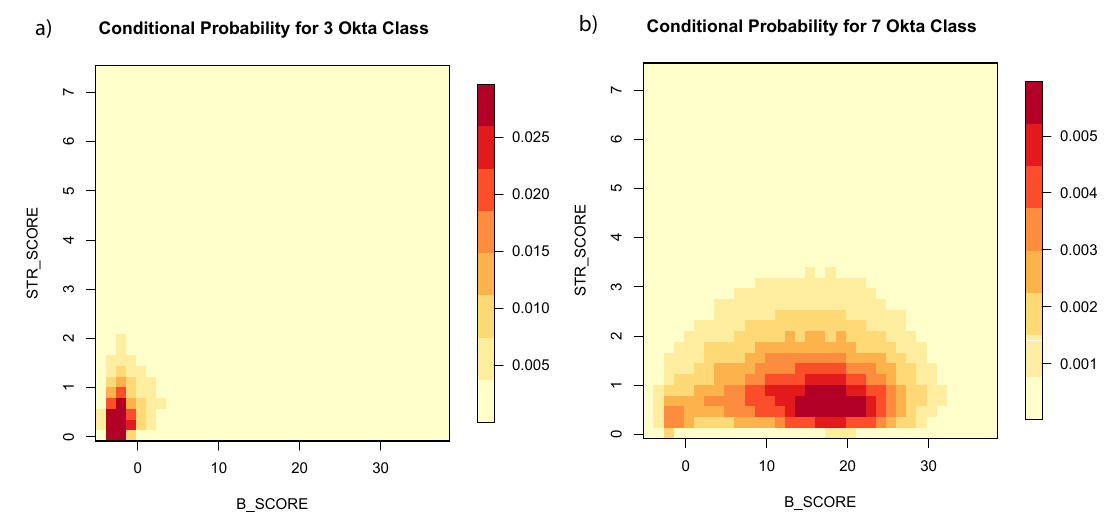
Figure 6. Two-dimensional joint histograms showing conditional occurrence probabilities for the 3 ( a ) and 7 ( b ) Okta CFC classes. The histograms explore the covariance between the state (B_SCORE) and spatio-temporal variability (STR_SCORE) of the solar